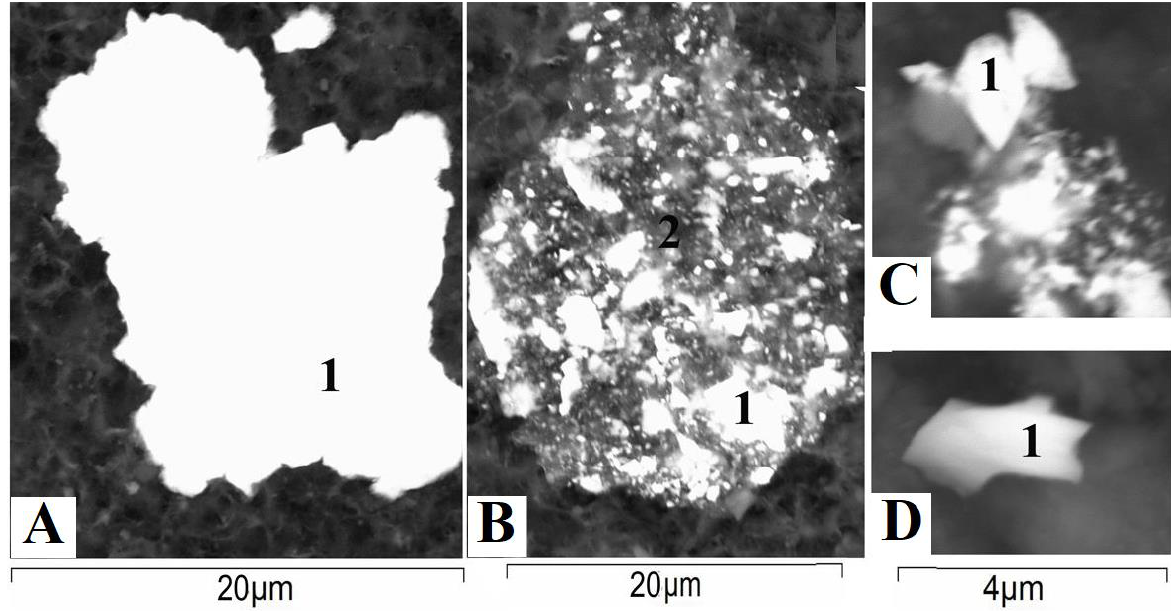
Figure 11. Micrographs made using SEM of aggregates of technogenic composition of various morphologies in river suspended matter on filters taken in the Suna ( A , B ) and Andoma ( C , D ) rivers: ( A ) 1 — Zn-Ni-Cu alloy aggregate; ( B ) 1 — Ni-Sn alloy aggregate and 2 — small grains of calcite in association with biodetrite of diatoms; ( C ) 1 — crystals and isometric grains of silver sulfate; ( D ) 1 — coalescence of grains of native antimony.